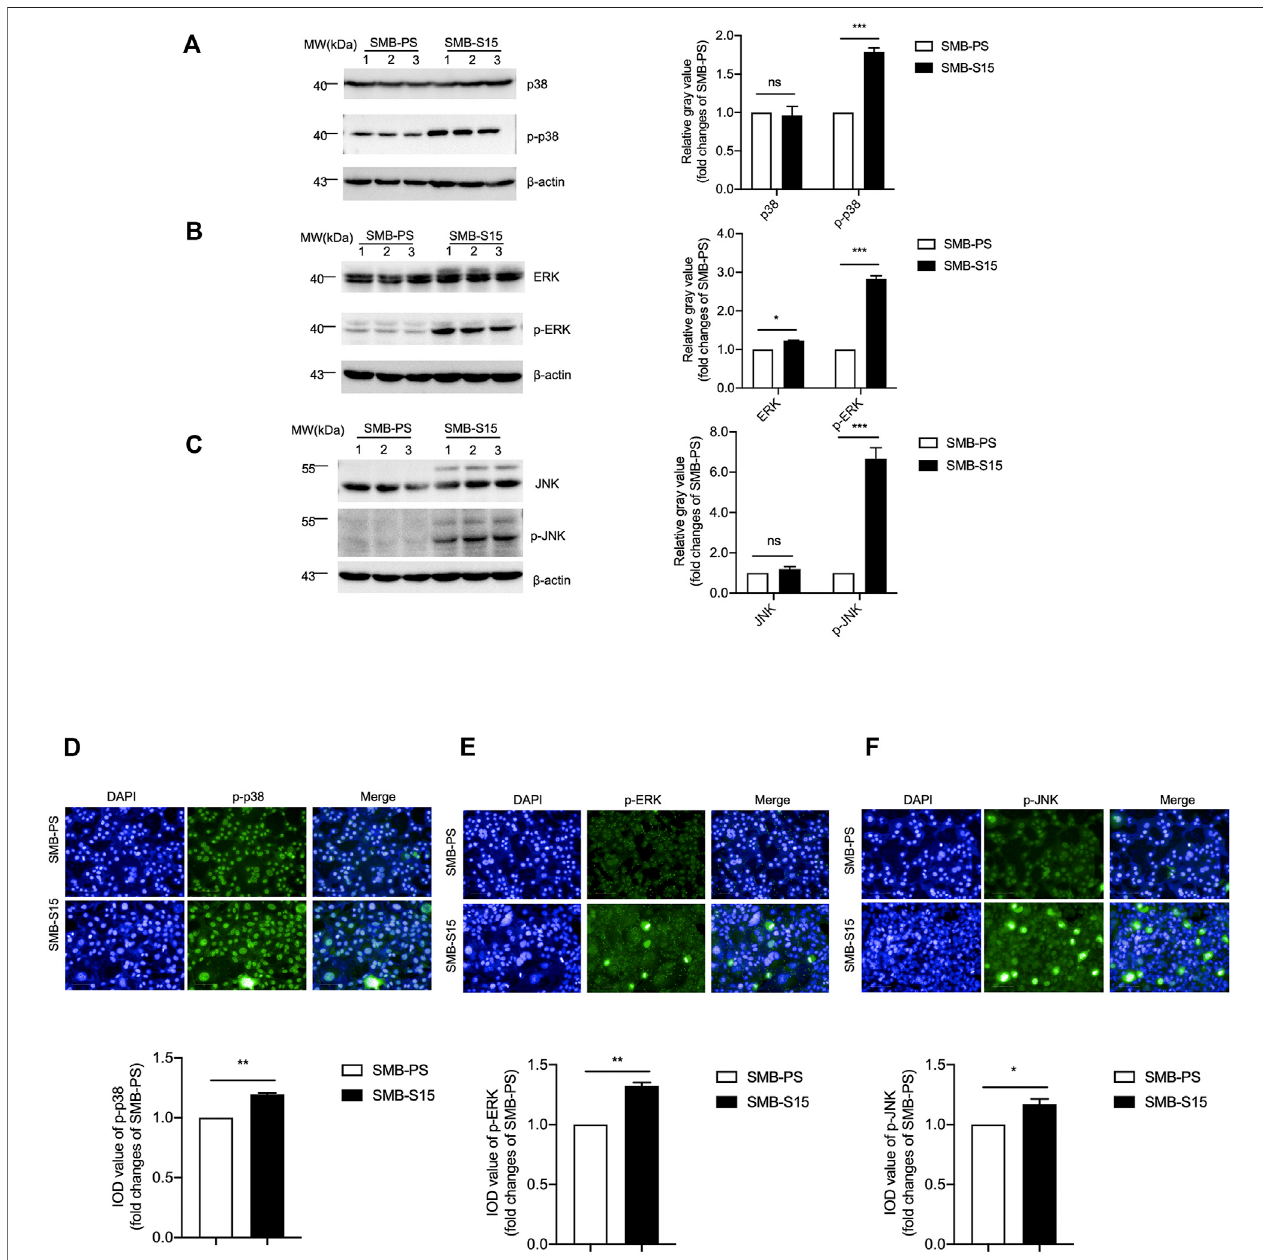
FIGURE 4 | Activation of the MAPK pathway in two SMB cell lines. (A-C) Left: Western blots for the levels of p38 and p-p38 (A) , ERK and p-ERK (B) , JNK and p-JNK (C) . Relative molecular weights are marked on the left. Two SMB cell lines are indicated above. (1, 2, 3) indicate the number of replicates. Right: Densitometric analyses of the average gray values of the signals of the target proteins after being equilibrated with that of β -actin. (D-F) Top: Immunocytochemical assays of the levels and distributions ofp-p38 (D) , p-ERK (E) , p-JNK (F) in two SMB cell lines. The images of DAPI (blue), p-38/p-ERK/p-JNK (green),and merge are indicated above. Bottom: The IOD analysis for the signals of p-38/p-ERK/p-JNK in the images of two SMB cell lines. The quantitative results are presented as mean + SEM. The IOD values of p-p38, p-ERK, and p-JNK in SMB-PS cells are set to 1 and Y -axis represents the fold changes in SMB-S15 versus SMB-PS.